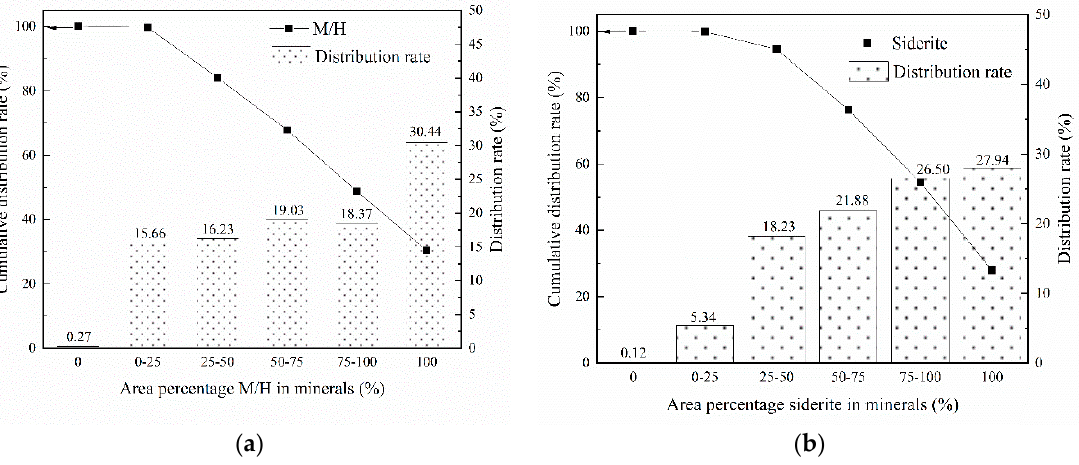
Figure 6. Liberation degree of major iron minerals. ( a ) M/H; ( b ) siderite.